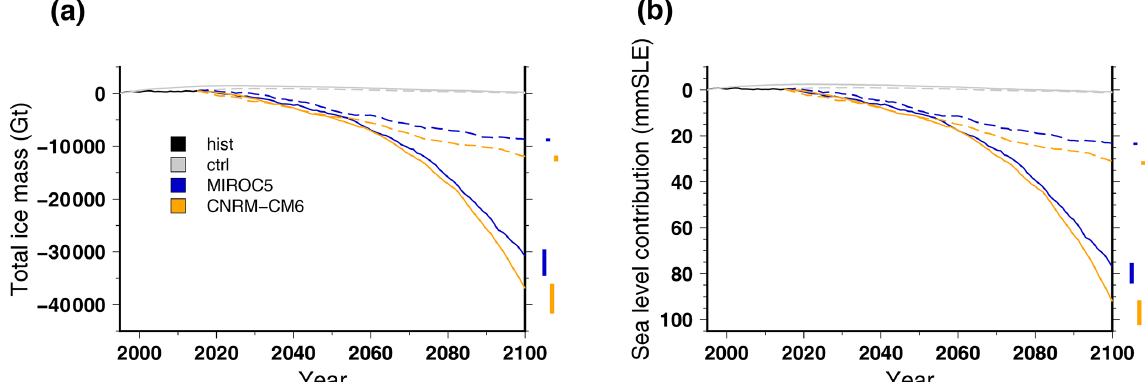
Figure 7. Simulated total ice mass change for the historical experiment hist (1995–2015), the control experiments ctrl (solid grey lines) and ctrl_proj (dashed grey lines) and for the projections using two climate models run under a high-emission scenario for greenhouse gases (solid lines; RCP8.5 for MIROC5 and SSP585 for CNRM-CM6) and a low-emission scenario (dashed lines; RCP2.6 for MIROC5 and SSP126 for CNRM-CM6) with a medium oceanic sensitivity, expressed as (a) total mass change and (b) ice volume contributing to sea level rise. For each projection experiment, the right-hand-side vertical bar shows the minimal and maximal changes associated with the oceanic-forcing uncertainty ( low and high